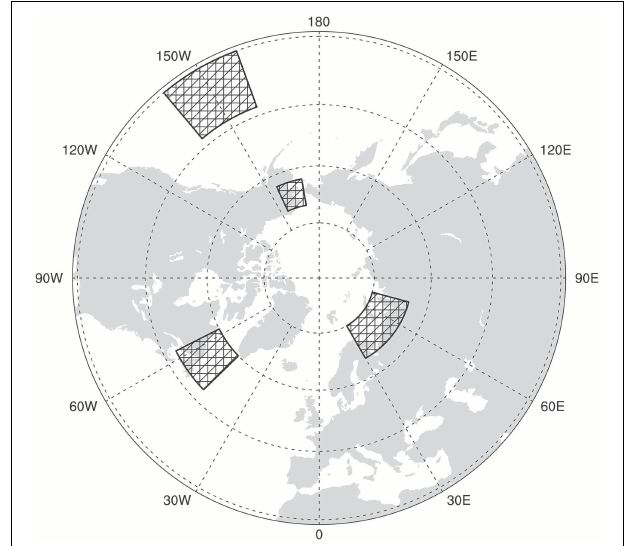
systems, as indicated by the vorticity, which represents how much the wind spins, with values higher than about 9 × 10 − 5 s − 1 . FIGURE 7 | Regions selected for the MSLP-based